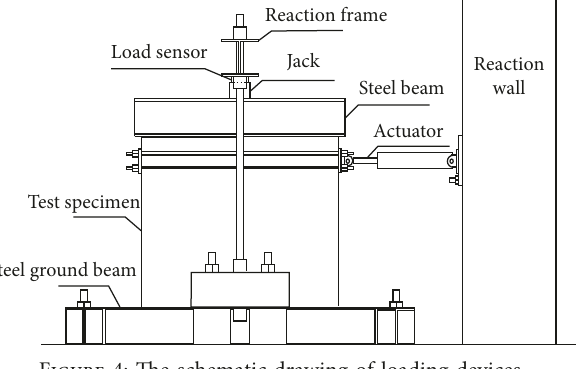
Figure 4: The schematic drawing of loading devices.